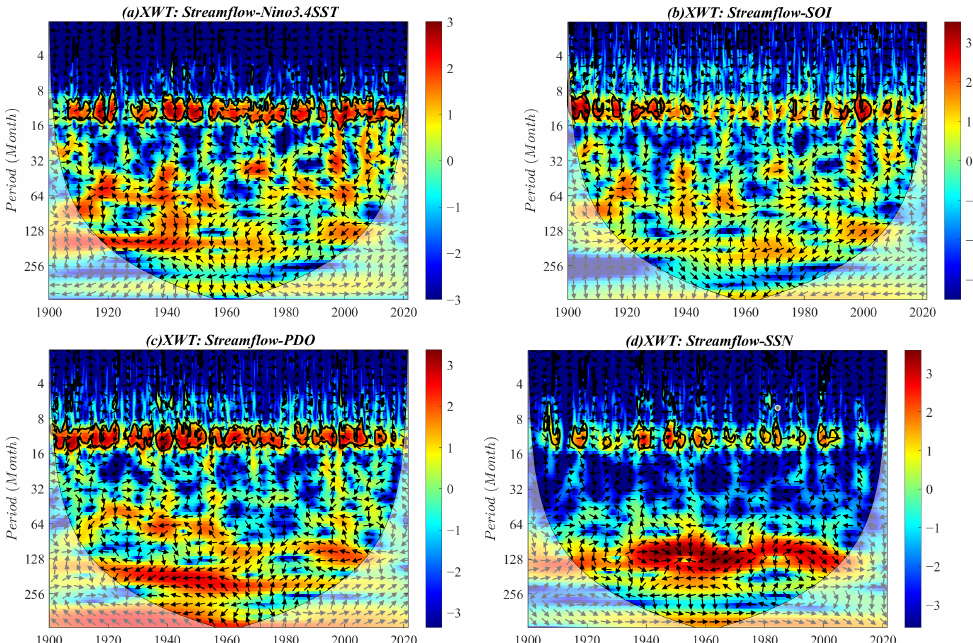
Figure 8. Cross-wavelet power spectrums between monthly streamflow time series and teleconnec- tions. ( a ) Streamflow-Nino3.4 SST; ( b ) Streamflow-SOI; ( c ) Streamflow-PDO; ( d )